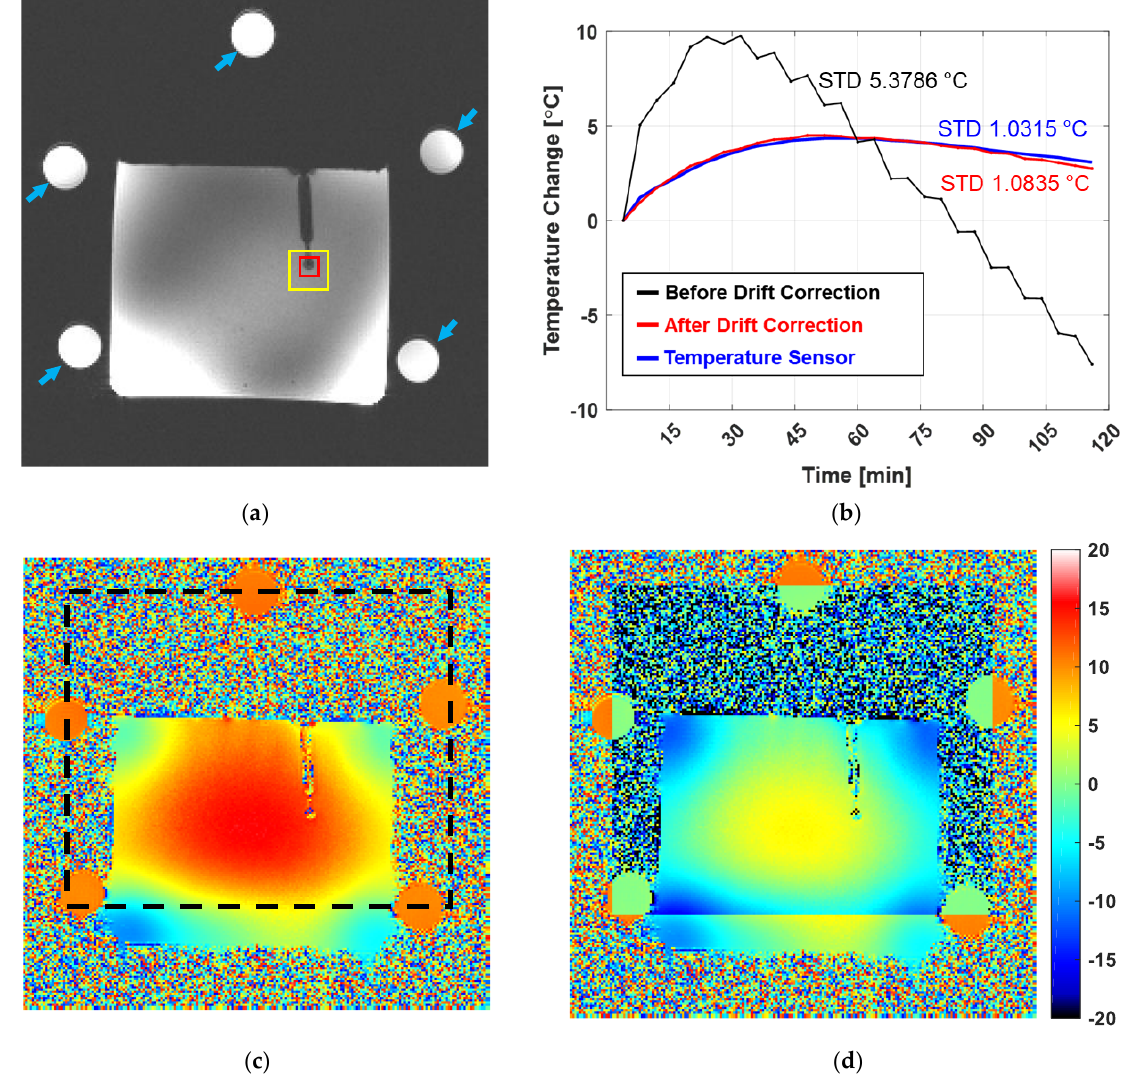
Figure 2. Agar-gel phantom experiment for validation of accumulative PRFS. ( a ) Magnitude MR image of agar-gel phantom. Blue arrows indicate the five reference oil phantoms for phase drift correction. The mean temperature changes (yellow box) were calculated around the tip of the fiber optic temperature sensor, except in the region of the susceptibility artifact (red box). ( b ) Tempera- ture changes measured by fiber optical temperature sensor (red line) and accumulative PRFS tech- niques (black and blue lines represent changes before and after correction, respectively). Standard deviation (STD) of each temperature measurement was placed with corresponding color. ( c ) PRFS image before phase drift correction. The black dashed box indicates the region of phase drift correc- tion using the five reference phantoms. ( d ) PRFS image after phase drift correction. The temperature in the central area was higher than that at the edges. The columnar dark region in the agar-gel phantom (Figure 2a) indicates the location of the fiber optic temperature sensor. The phase drift correction to the accumulative MR temperature imaging was validated by comparison with the temperature measurements obtained using the optic temperature sensor. The mean value within 5.25 mm 2 (7 × 7 pixels in yellow box in Figure 2a) of each accumulative PRFS temperature image was taken, ex- cept in the region around the susceptibility artifact (red box in Figure 2a). The measured temperature values (red line in Figure 2b, after phase drift correction) were compared with the fiber optic temperature readings (blue line in Figure 2b, reading at the red box in Figure 2a). The mean phase values in a 5 × 5 pixel area at each of the five oil phantoms (five points in total) were taken to estimate the spatial and temporal variations in the phase drift at each phase change. The dashed box in Figure 2c indicates the area of the phase drift correction, which was interpolated from the five reference points. The estimated phase drift was then subtracted from the original phase change as expressed in Equation (1). Figure 2c,d show the PRFS images before and after the phase drift correction, respec- tively. 2.2. In Vivo Brain Temperature Imaging under General Anesthesia We scanned the accumulative MR temperature of eight canines (beagle dogs) with a mean weight of 8.9 ± 2.1 kg with various body conditioning scores (BCS, body condition- ing score; 1 – 9, with the higher number indicating greater obesity) that indicate the degree of obesity of individual subjects [14]. Each canine was administered 6 mg/kg of intrave- nous (IV) propofol (Provive injection 1%, Baxter, Newbury, UK) and scanned in the ster- nal recumbency position. The canines were mechanically ventilated during the experi- ments using an animal ventilator (Vetia animal model/ANY VENT, J&TEC, Gimpo, Ko- rea) with a respiration rate of 10 time/minute, and 2 – 3% isoflurane (Terrell, Piramal